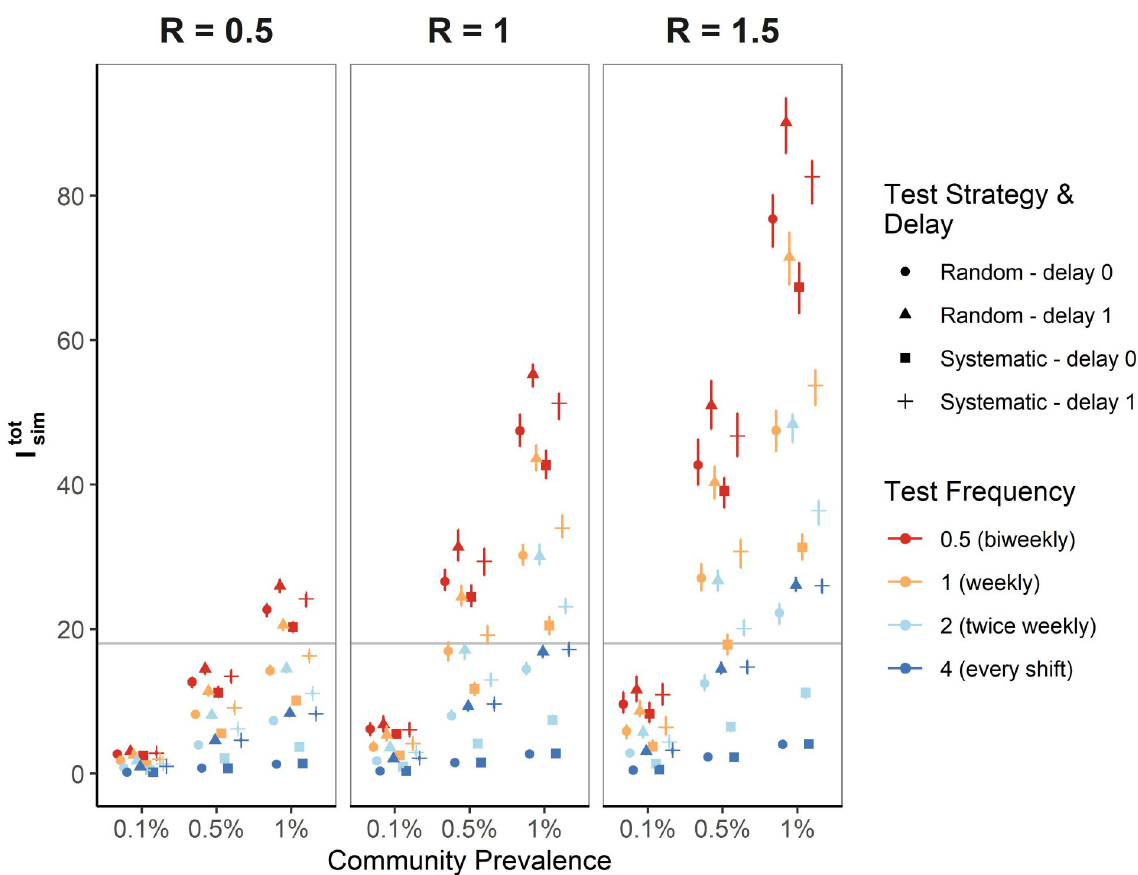
Fig 3. Number of expected infections generated in a facility from model simulations comparing random and systematic testing strategies across transmission scenarios, test frequencies, and delays isolating infectious individuals who have tested positive. Systematic testing strategies ( ■ , ➕ ) prevent more infections than random strategies ( ● , ▲ ) across all transmission scenarios (indicated by community prevalence across the x axis and by reproduction number across the panels) and test frequencies (indicated by different colored symbols with blue corresponding to the highest test frequency of 4 tests per week and red the lowest test frequency of biweekly testing). More infections are expected in transmission scenarios with higher within-facility R and higher community prevalence. Preventing delays between testing and isolation of positives (squares compared to crosses and triangles compared to circles) and increasing test frequency (red = lowest frequency, blue = highest frequency) also reduces the number of infections. The horizontal gray line serves as a reference to assess the testing frequency needed to maintain I tot � 18 (corresponding to one infection every ten days) across different transmission scenarios. Error bars represent the sim interquartile range of I tot derived from 100 simulations per scenario run for 180 days among 700 staff. sim